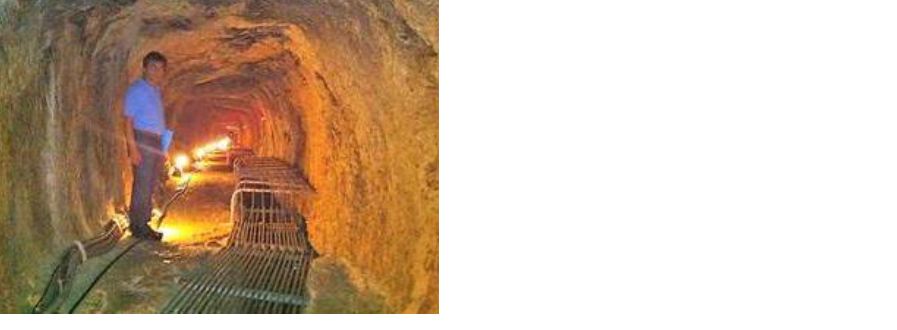
Figure 7. The endless screw of Archimedes based on the description of Vitruvius [54,55].